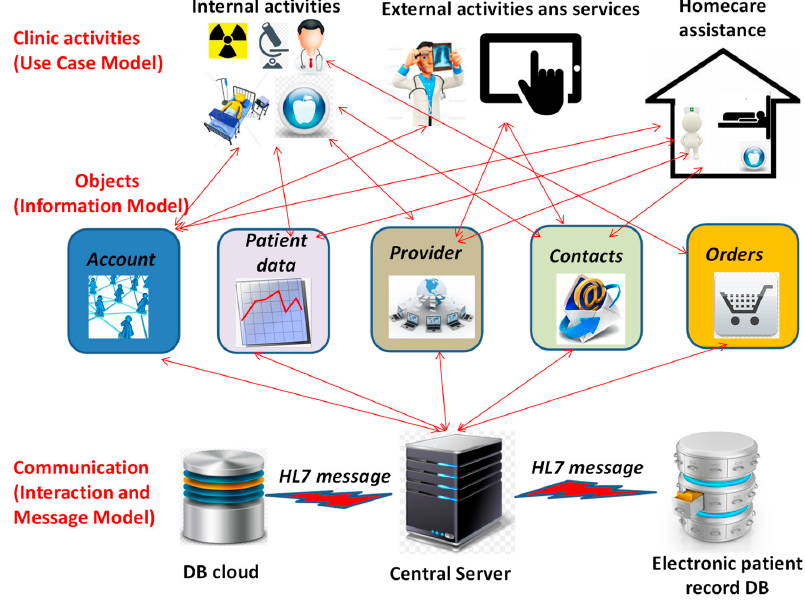
Figure A3. HL7 as communication protocol.